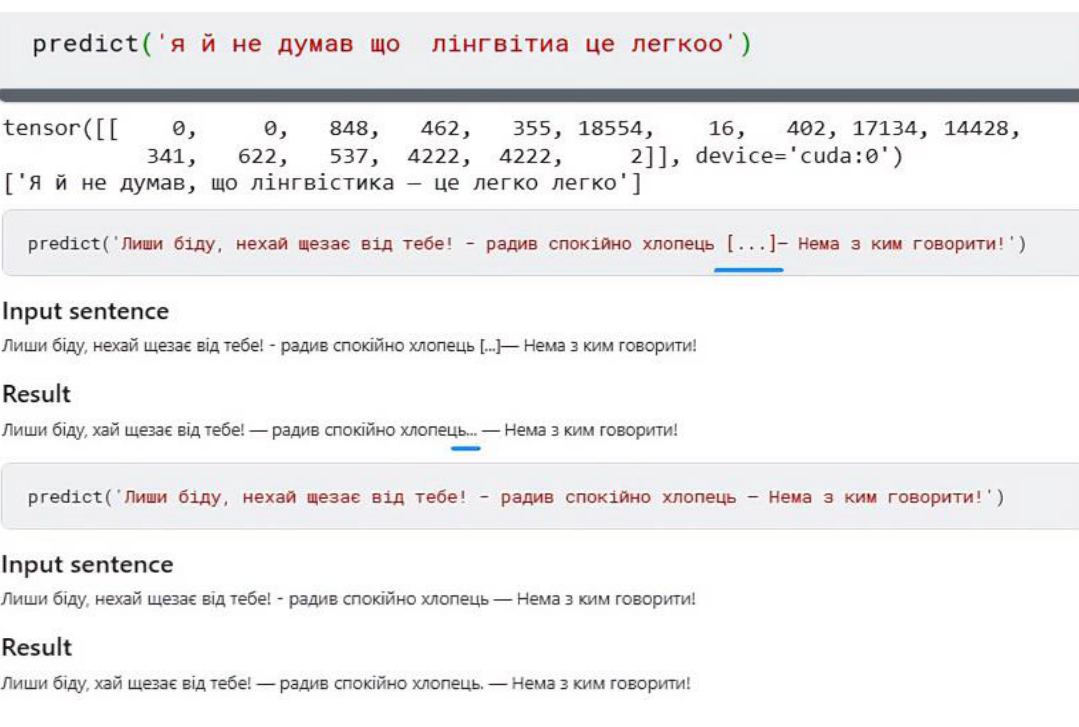
Figure 9. Placing punctuation marks.